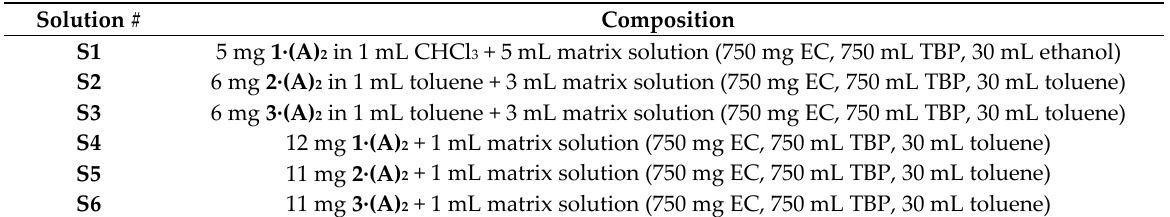
Table 2. Composition of the solution with the colorimetric compounds.